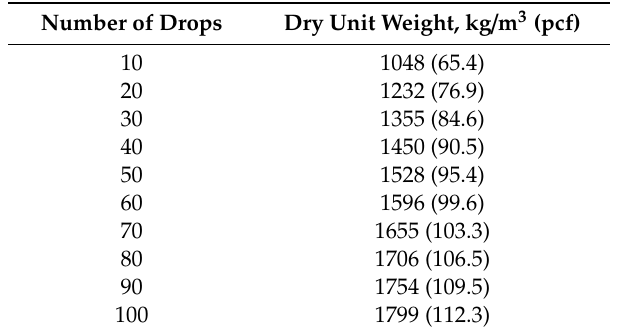
Table 2. Calculated dry unit weight (kg / m 3 ) and number of required drops.